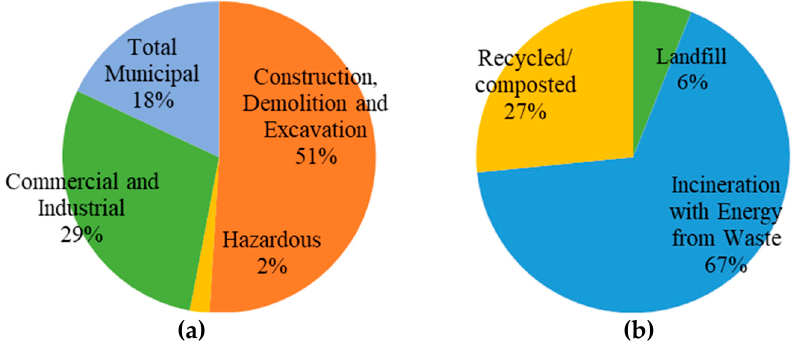
Figure 2. ( a ) Types of waste distribution for Birmingham; ( b ) Municipal Solid Waste (MSW) treatment (2013/14) for Birmingham (percentage amounts by